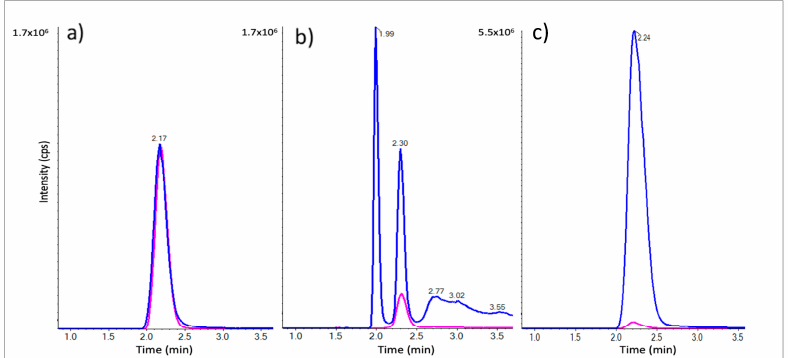
Figure 1. LC-MRM chromatograms of β -ODAP in blue ( m / z 177.0 → 116.0 ) and Gly-Asp in pink ( m / z 191.0 → 116.0 ) for a standard mix of 12.5 µM each ( a ) and L. sativus raw extract spiked with Gly-Asp following protein precipitation with ACN ( b ) and with the MAX-SPE step added ( c ).